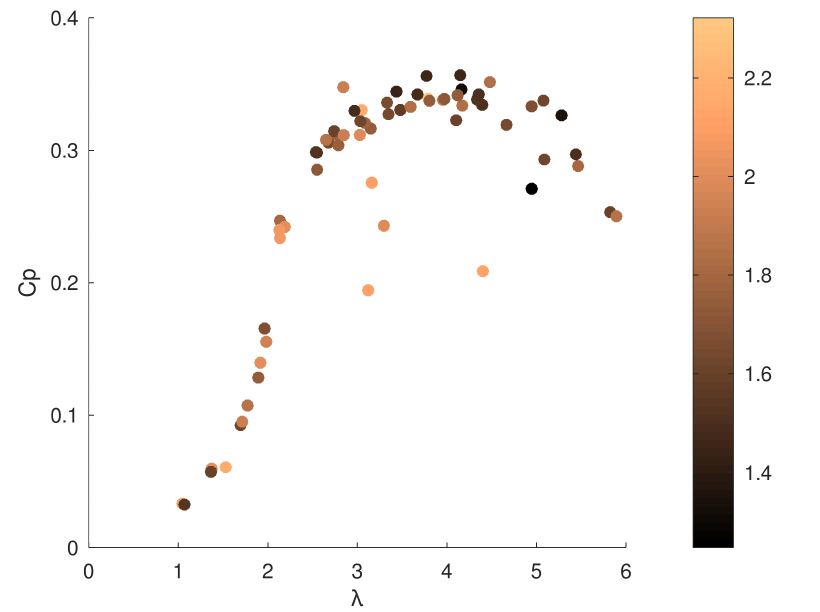
Figure 10. C p – λ data based on filtered steadiest 30 s samples from V1. Coloured by mean velocity (m/s).